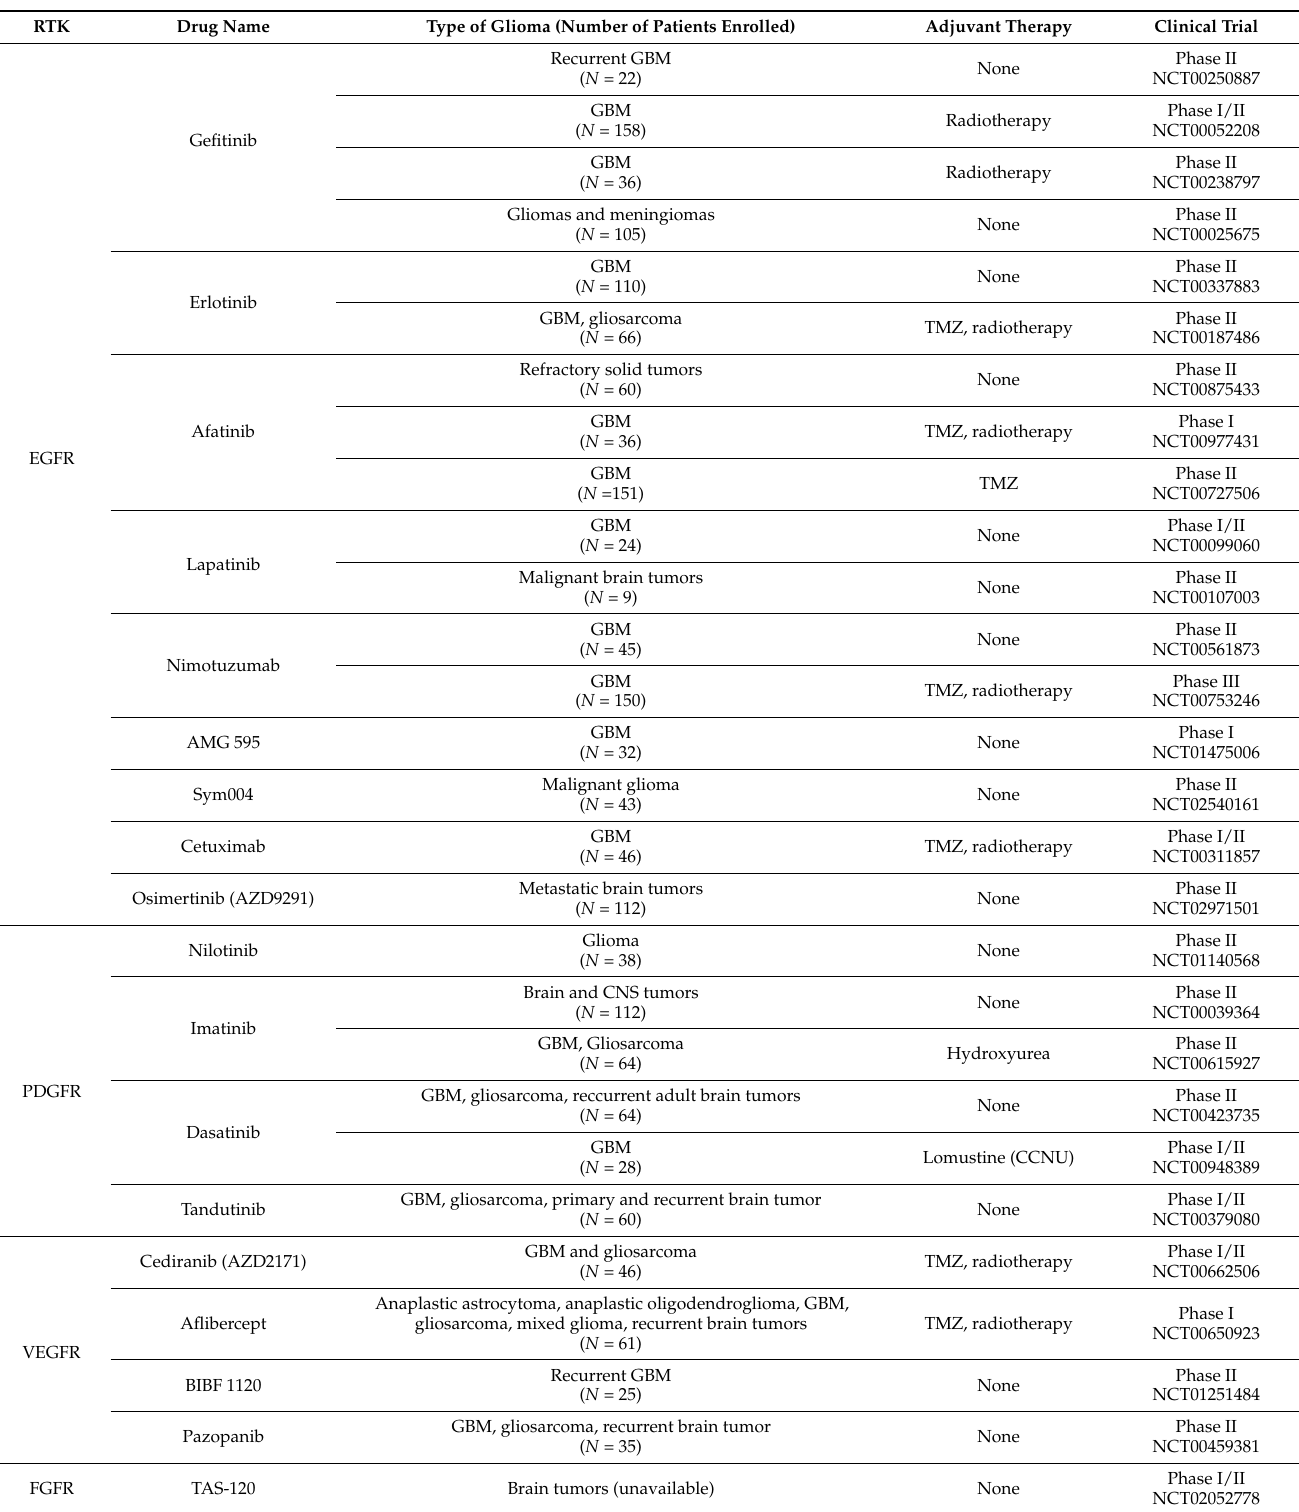
Table 1. Ongoing clinical trials on adult gliomas targeting RTKs (data from http://clinicaltrials.gov, accessed on 30 April 2021).